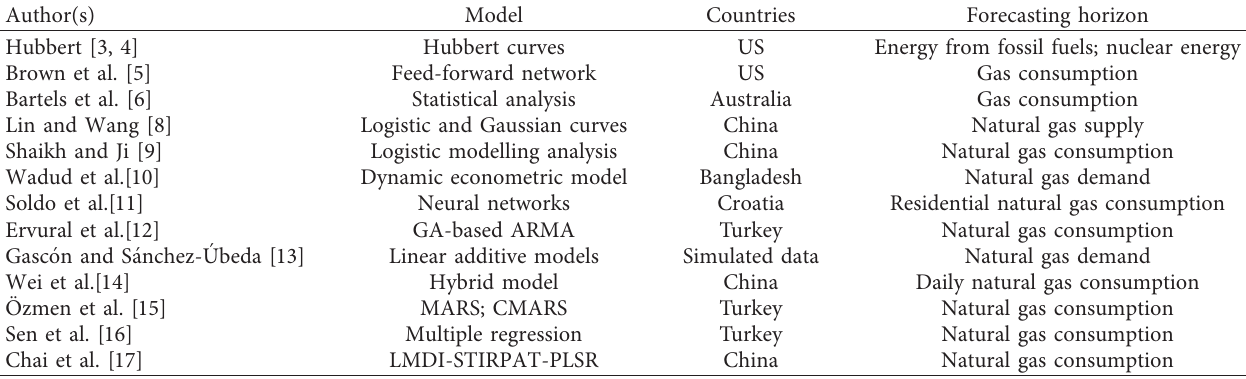
Table 1: Summary of the empirical literature in Section